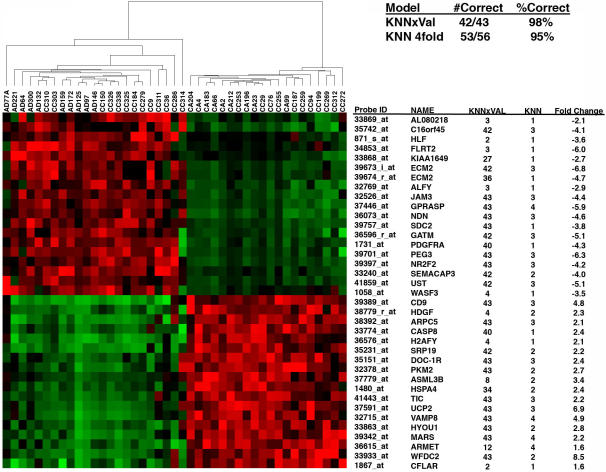
Two-dimensional hierarchical clustering of 43 samples is shown using a set of 36 probe sets that were employed in at least one KNN predictive model and two or more KNNxVal models.To the right of the clustering pattern are given the probe set ID, HUGO Gene Symbol, number of models that each probe set appeared, and the fold change for each probe set for carcinoma-like vs. adenoma-like samples. Also shown are the number and percent correct predictions made by the 43 KNNxVal models and the four KNN models (upper right panel).